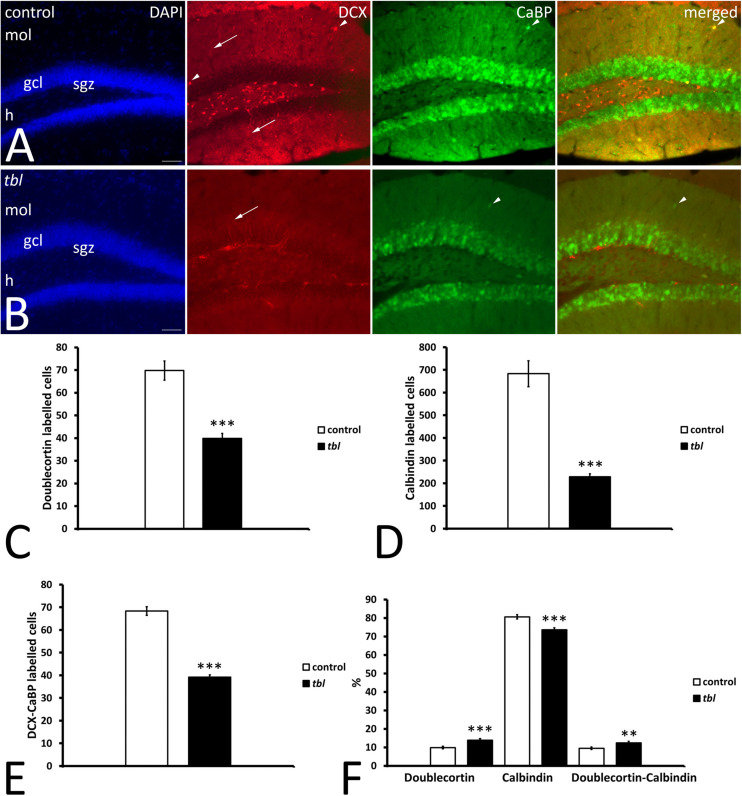
Microphotographs of coronal sections through the dentate gyrus of control (A) and tbl mice (B) illustrating DCX and CaBP immunoreactivity. DCX labeled cells occupy the subgranular zone, spreading their dendrites through the granule cell layer toward the molecular layer (arrows), while CaBP immunoreactive cells lie within the granule cell layer. A few labeled cells can be detected in the molecular layer (arrowheads). (C–F) Graphical representation of the number of DCX (C), CaBP (D), and DCX-CaBP (E) labeled cells, and the proportions of single and double-labeled cells (F). The dentate gyrus of control mice possesses significantly more DCX, CaBP, and DCX-CaBP labeled cells than in tbl mice (C, ***p = 2.0063654E–08; D, ***p = 2.387923 E–10; E, ***p = 1.665851E–12). However, the percentages of single and double labeled cells indicate that tbl mice possess significantly fewer calbindin immunoreactive neurons in the dentate gyrus than the controls (F, ***p = 0.0000242). By contrast, a higher proportion of DCX and DCX-CaBP labeled cells is found in the tbl dentate gyrus than in the controls (F, ***p = 0.0004682; and **p = 0.0060857, respectively), gcl, granule cells layer; h, hilus; mol, molecular layer; sgz, subgranular zone. Bar = 50 μm (A,B).